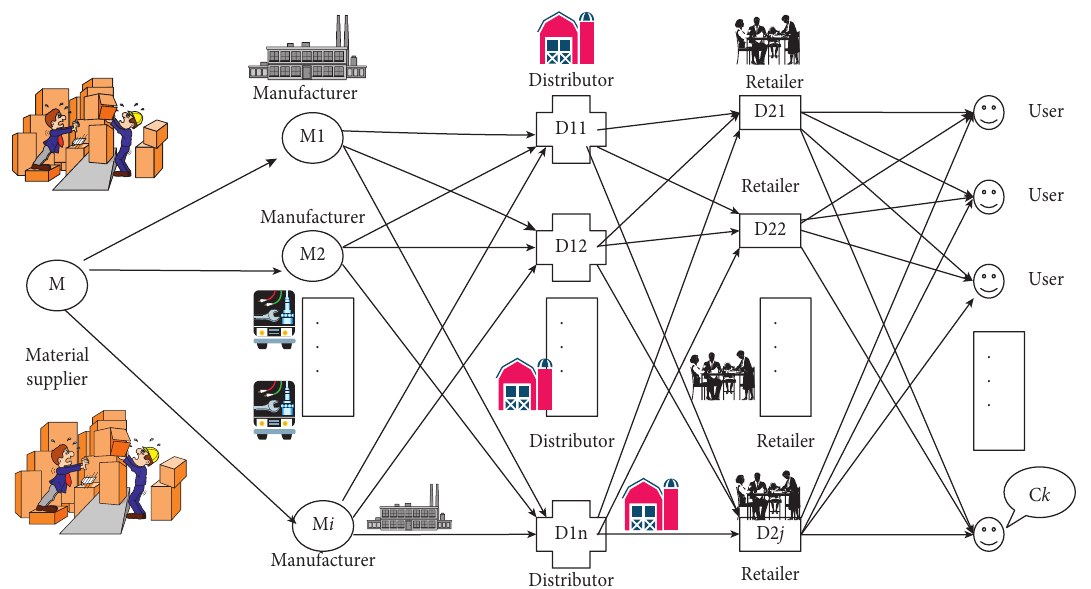
Figure 4: Framework of supply chain model